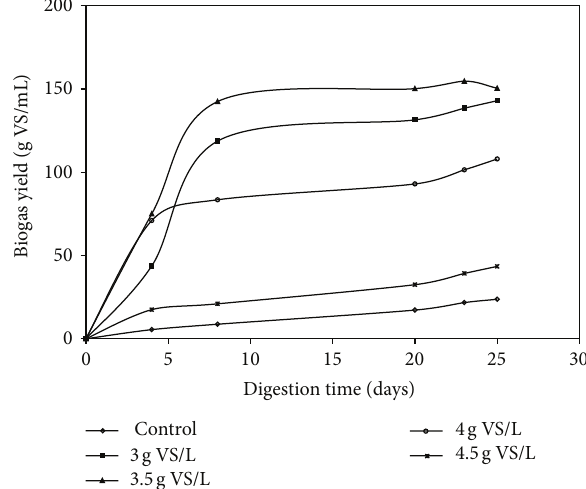
Figure 2: Biogas yield for coconut oil cake at different volatile solid rates.